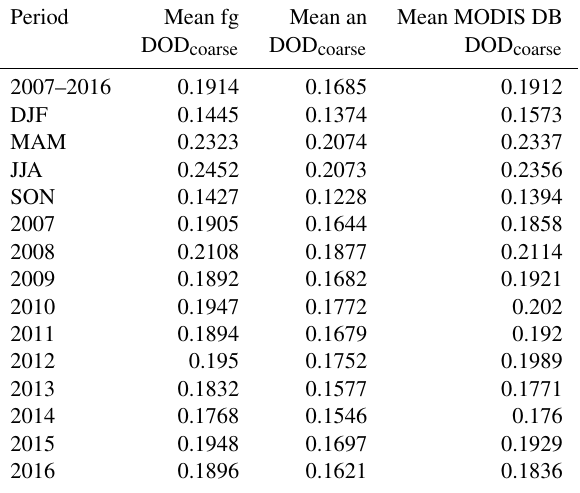
Table 4. Averaged DOD coarse of observation-collocated first guess (fg), observation-collocated analysis (an) and assimilated MODIS DB retrievals for the full period (2007–2016), for different seasons (DJF, MAM, JJA, SON) and for individual